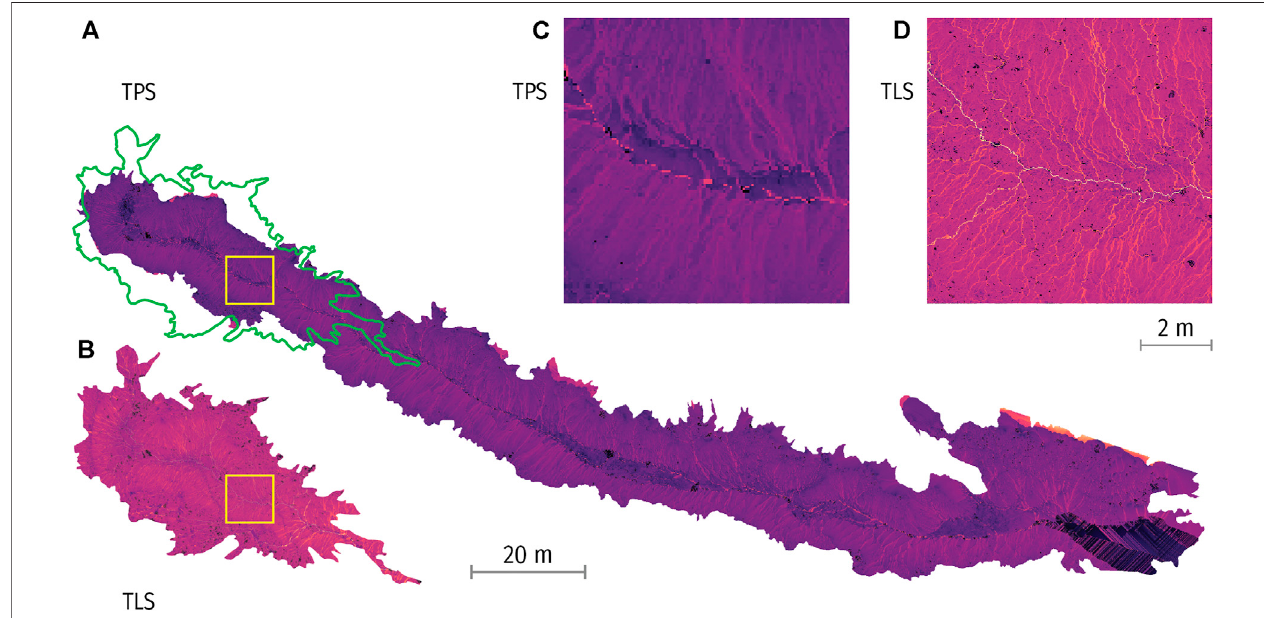
FIGURE 10 | Sediment connectivity maps of (A) TPS model and (B) TLS model, with some enlarged details of (C) TPS and (D) TLS.